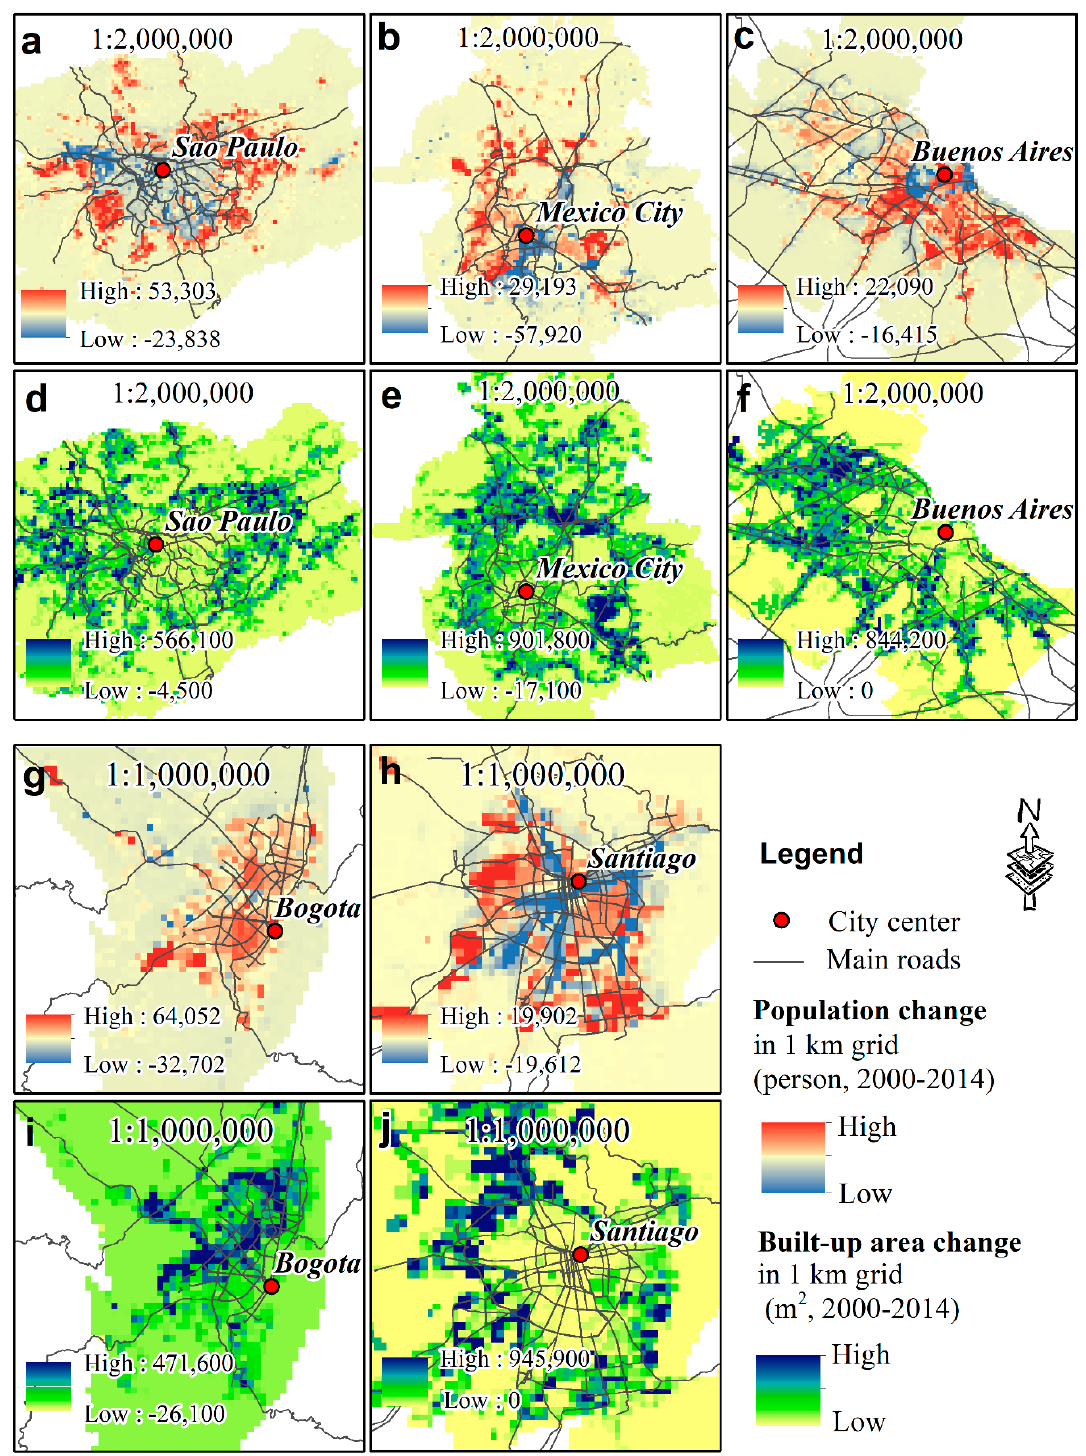
Figure 6. Spatial distributions of population changes ( a – c , g , h ) and built-up area changes ( d – f , i , j ) from 2000 to 2014 in five Latin American cities. Only three types of roads (trunk, primary, motorway) were preserved from the OSM road net (https://www.openstreetmap.org) (accessed on 20 April 2021).